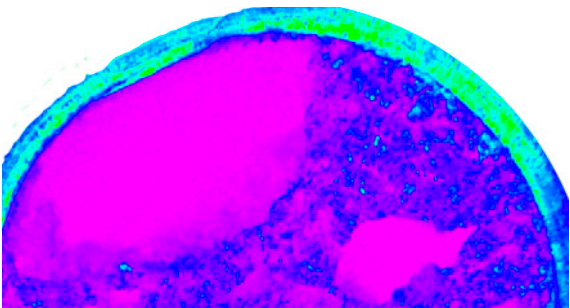
Figure A2. Pseudo-color analysis of a 15 mm diameter copper sheathed ZVI desalination pellet (Used in Trial ST1c [16]). Porosity = purple; Residual Fe 0 = green; Fe x O y H z = blue; Cu 0 sheath = green; Structural Porosity = 76%. ZVI: water ratio = 25.38 g/L; Feed water salinity = 8.19 g/L; Product water salinity after 230 days = 1.48 g/L. NaCl removed = 6.71 g/L (0.26 g/g ZVI). Feed Water pH = 6.21; Product water pH = 8.54. Pore classification: Macropores (>50 nm), the pore size distribution is multimodal with a mixture of largely interconnected, high surface area, sinusoidal, bulbous pores characterized by one or more narrow pore throats. The characteristics of fluid flow in this type of pore network are described in references [62–65,88,89].